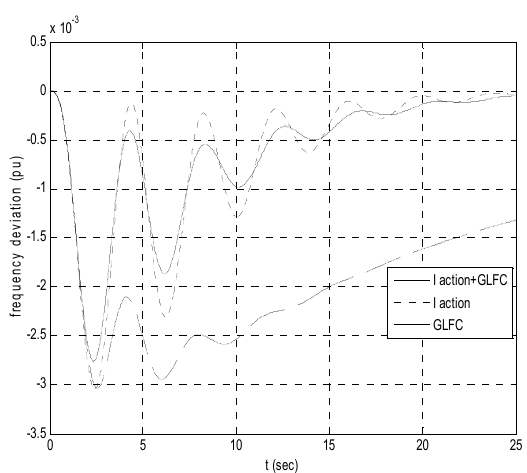
Designs 2019 , 3 , x FOR PEER REVIEW